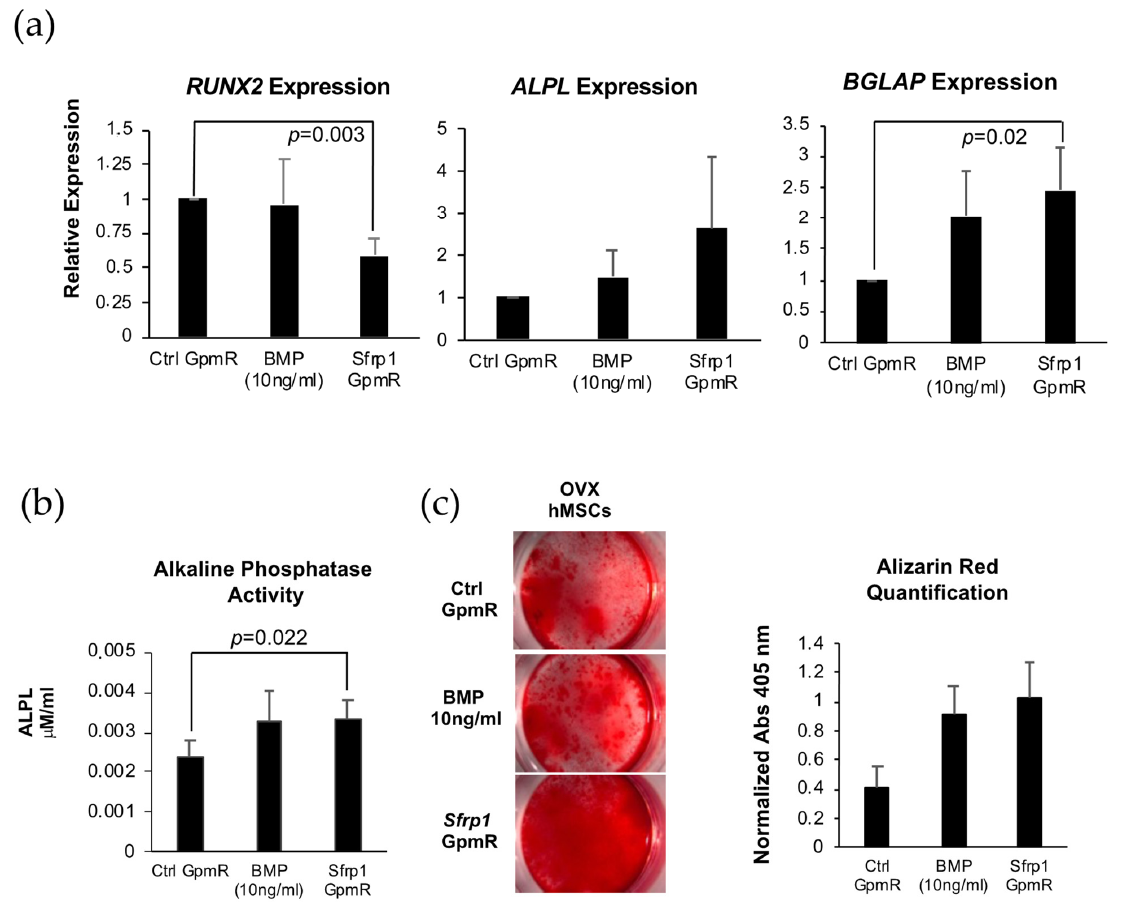
Figure 5. Effect of SFRP1 silencing on the osteogenic potential of human MSCs from osteoporotic patients. All analyses were performed at 21 days of osteogenic differentiation. ( a ) Semi-quantitative PCRs showing the relative expression levels of different osteogenic markers ( RUNXx2, ALPL, and BGLAP ) in hMSCs from osteoporotic patients (MSC-OP) transfected with a control GapmeR (Ctrl) and a GapmeR for the silencing of SFRP1 expression. The expression of the analyzed markers in the presence of 10 ng/mL of BMP-2 was used as a reference of the effectiveness of SFRP1 silencing. Values reflect aver- ages of five different samples ( n = 5). Technical triplicates were also performed with each individual sample. ( b ) Graph showing the ALPL activity in MSC-OP under the different experimental conditions analyzed. Graph shows average values of five independent samples. ( c ) Osteogenic differentiation of the same hMSCs-OP transfected with the SFRP1 GapmeR or differentiated in the presence of 10 ng/mL BMP-2 as revealed by Alizarin Red staining. Results from one representative sample are shown in the pictures. Bar graph represents quantification of the staining. In all graphs, bars represent standard error of the mean values. p -values are indicated. 4. Discussion The numbers and potency of MSCs are key to maintaining normal bone physiology, therefore, modifications aimed to increase MSCs osteogenic potential could result in being highly useful to develop efficient therapies to promote bone regeneration. Modulating the two main osteogenic pathways, the BMP and the Wnt/ β -catenin signaling pathways, in order to increase or extend their activity seems a reasonable approach to achieve this goal. We have previously shown that transiently silencing Smurf1 , one of the main inhibitors of the BMP pathway, using LNA-ASOs, leads to a significant increase in bone formation, even in the presence of low BMP doses [6]. This modification of MSCs allowed us to in- crease bone formation by at least 30%. In this current work, we set out to further improve this system in order to achieve superior bone regeneration by targeting other inhibitors of the two main osteogenic pathways.